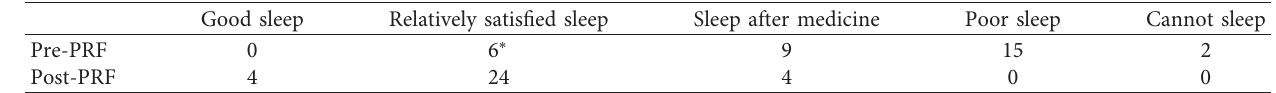
Table 4: The number of patients with different sleep quality levels, pre- and post-PRF ( n �